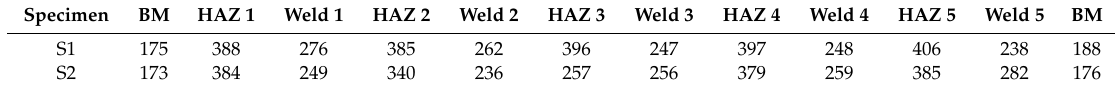
Figure 7. Hardness measurement results for specimens S1 and S2. Table 6. Average HV10 hardness measurements results.